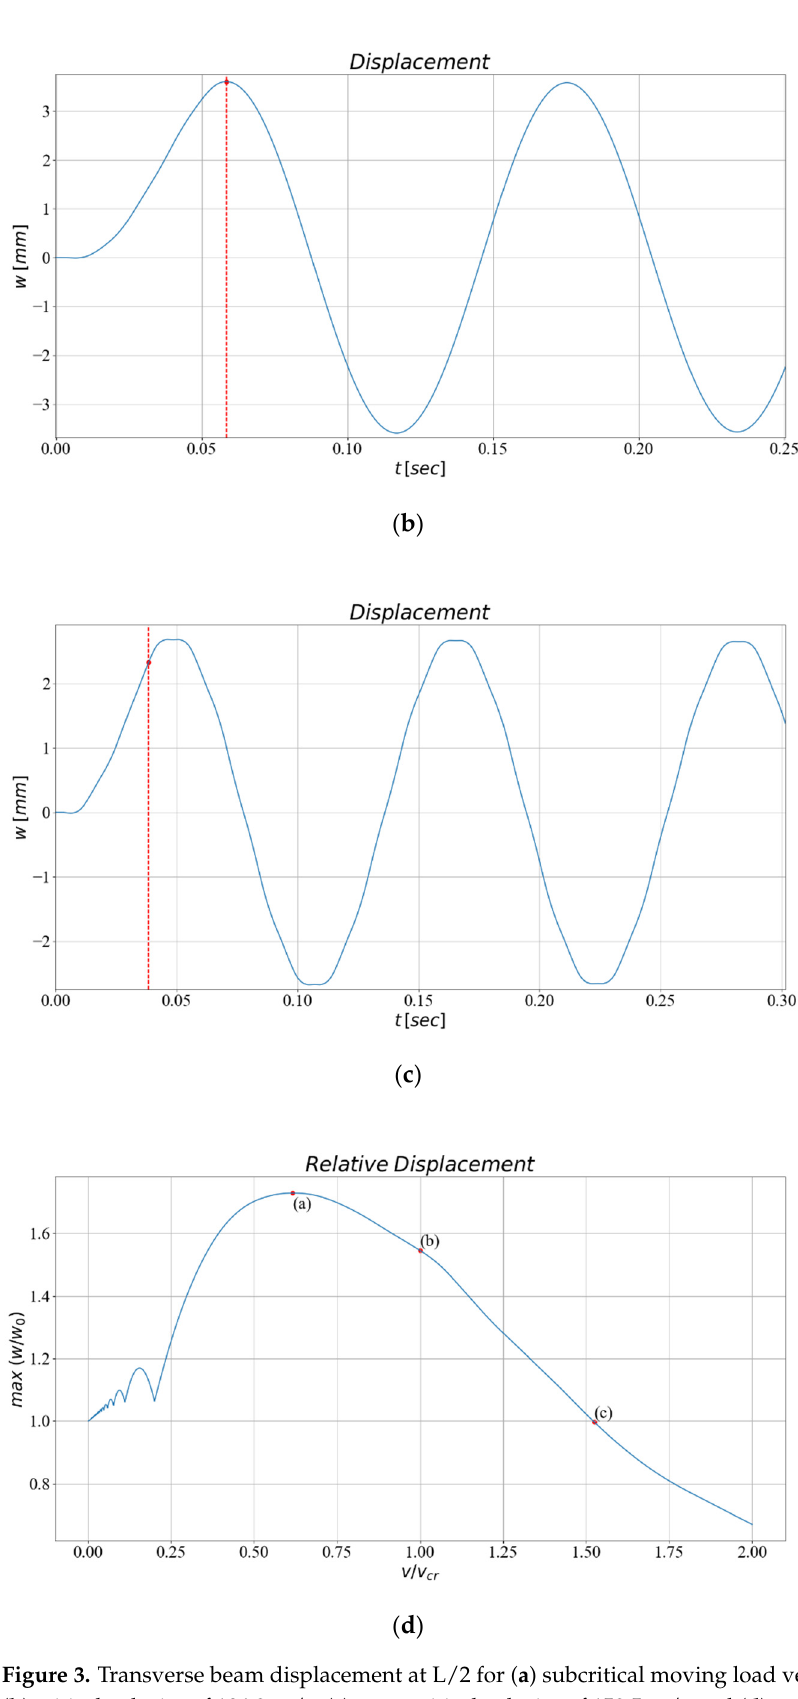
Figure 3. Transverse beam displacement at L/2 for ( a ) subcritical moving load velocity of 64.7 m/s, ( b ) critical velocity of 104.9 m/s, ( c ) supercritical velocity of 159.5 m/s and ( d ) maximum transverse displacement for all three load velocities. Note: The three red dots associate with cases ( a – c